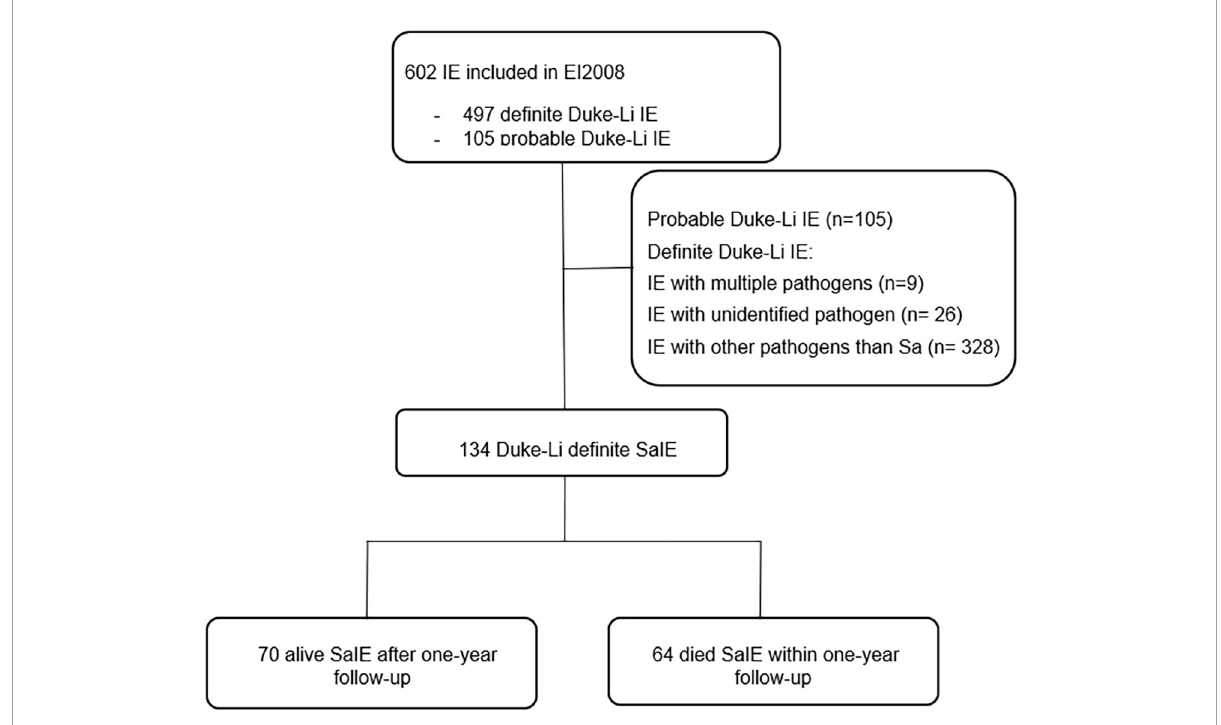
FIGURE1 Flow chart of patients with Staphylococcus aureus infective endocarditis (SaIE) selected from EI2008. IE, infective endocarditis, Sa, Staphylococcus aureus